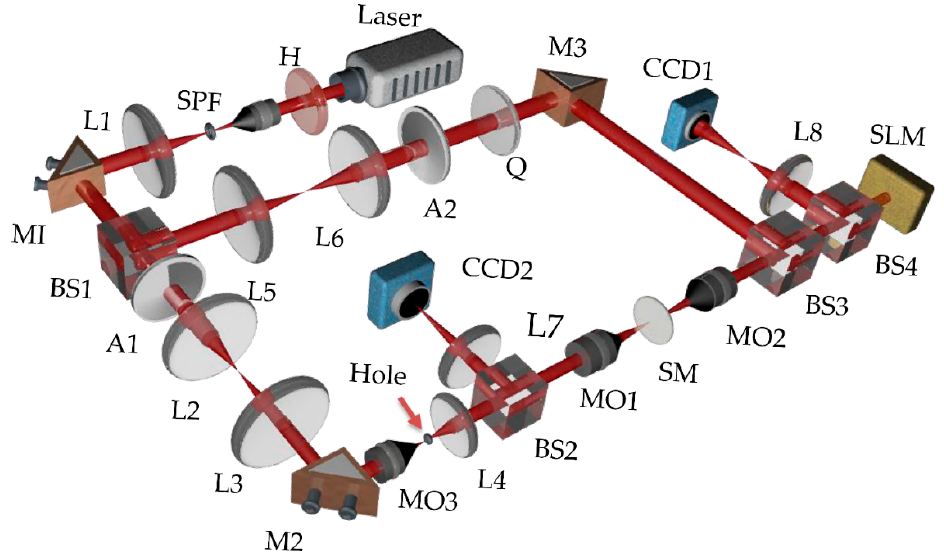
Figure 2. Experimental setup for the DOPC system. M1-3 are reflecting mirrors; H is the half-wave plate; SPF represents the spatial filter; A1–2 are the beam attenuators; BS1–4 are beam splitters; L1–8 are aspherical lenses, and the corresponding focal lengths are 100, 100, 100, 50.8, 100, 200, 100, and 100 mm, respectively; SM is the scattering medium; SLM is the spatial light modulator; MO1–3 are microscope objectives; Q is the quarter-wave plate; CCD1 and CCD2 are charge-coupled devices.